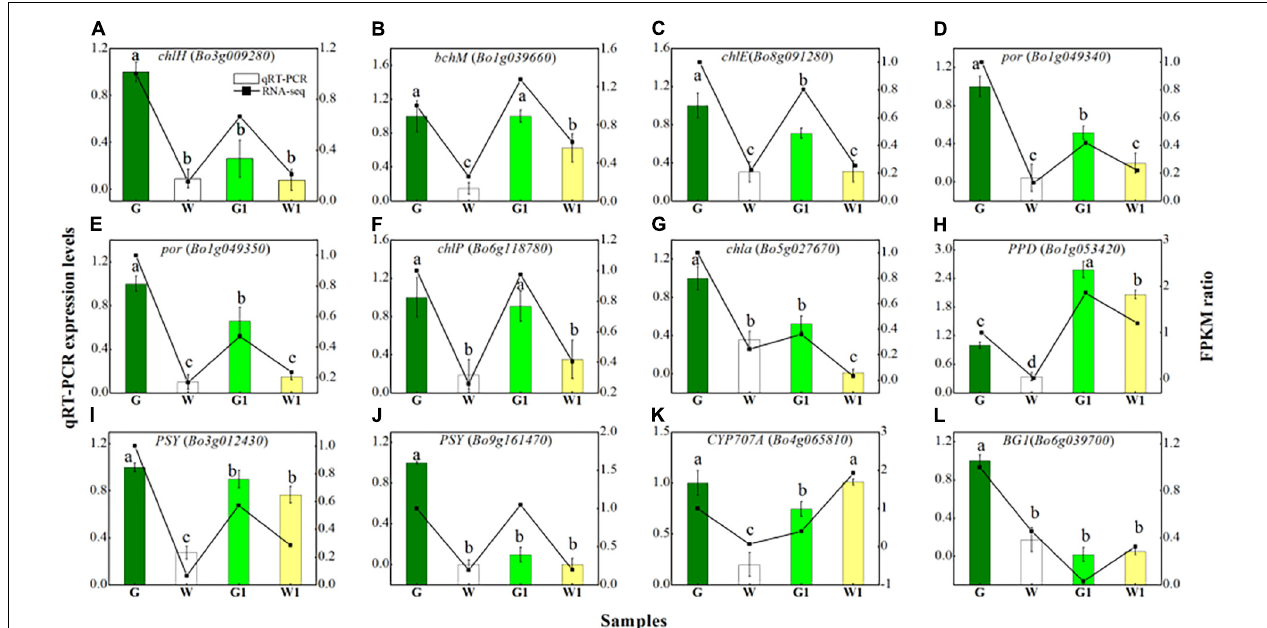
FIGURE 7 | Quantitative real-time PCR validation of eight DEGs (A–H) related to porphyrin and chlorophyll metabolism and four DEGs (I–L) related to carotenoid biosynthesis in four sample groups. Vertical bars represent the standard deviation of the means ( n = 3). Different letters: statistically significant differences ( P <